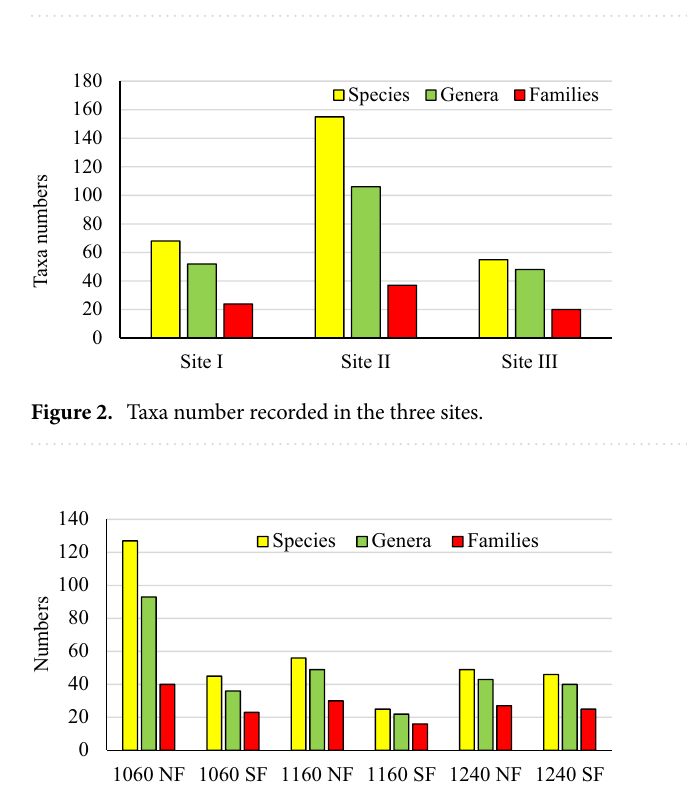
Table 2. Soil parameters registered along with the three sites of the studies area, EC, electrical conductivity; OM, organic matter; N, total nitrogen. Values are means of 5 replicates ± standard deviation.